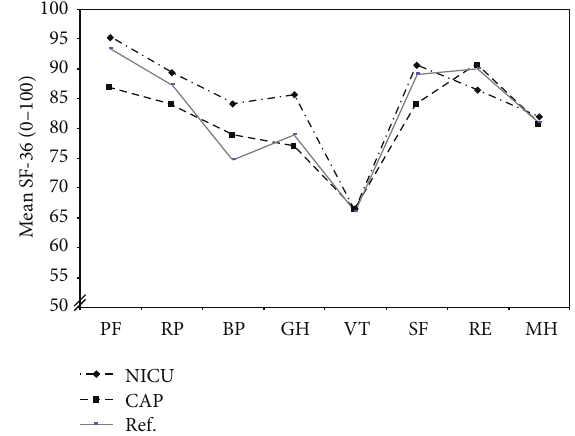
Ref. Figure 2: Mean values for eight subscales of SF-36 (see below) for nurses from the neonatal intensive care unit (NICU) and the child and adolescent psychiatry inpatient ward (CAP), respectively, compared with a reference sample of Swedish women ( 𝑛 = 515 ) working in health care